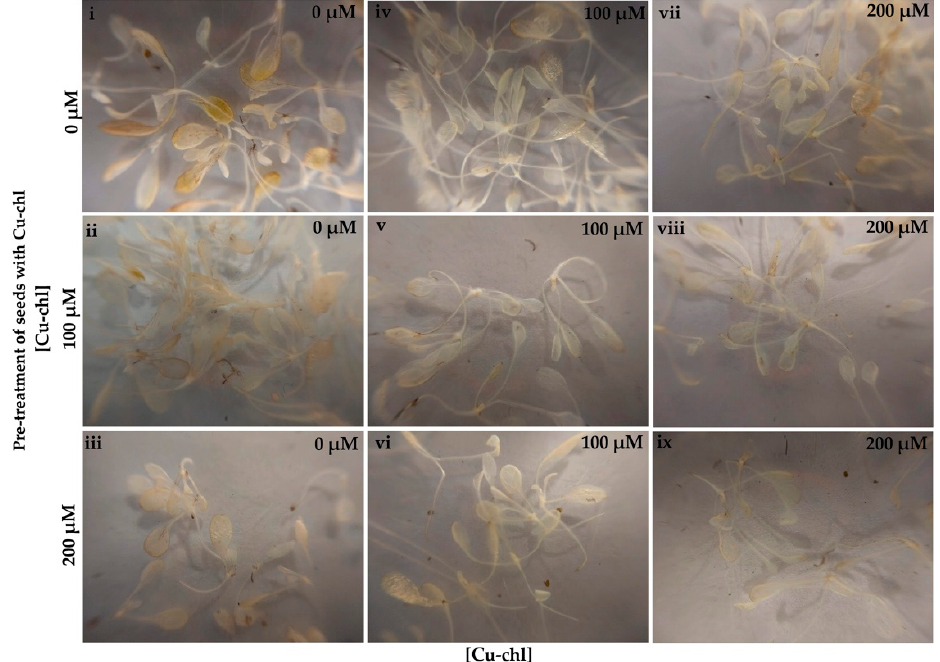
Figure 3. DAB staining of 2-week-old Arabidopsis seedlings pre-treated with Cu-chl and incubated with 100 nM paraquat for 3 h. Cu-chl was applied as seed treatment (concentrations indicated on the left) and in the growing media (concentrations indicated on the top right corner of each image) followed by paraquat treatment. Note the stronger DAB staining in leaves in the absence of Cu-chl treatment (i).